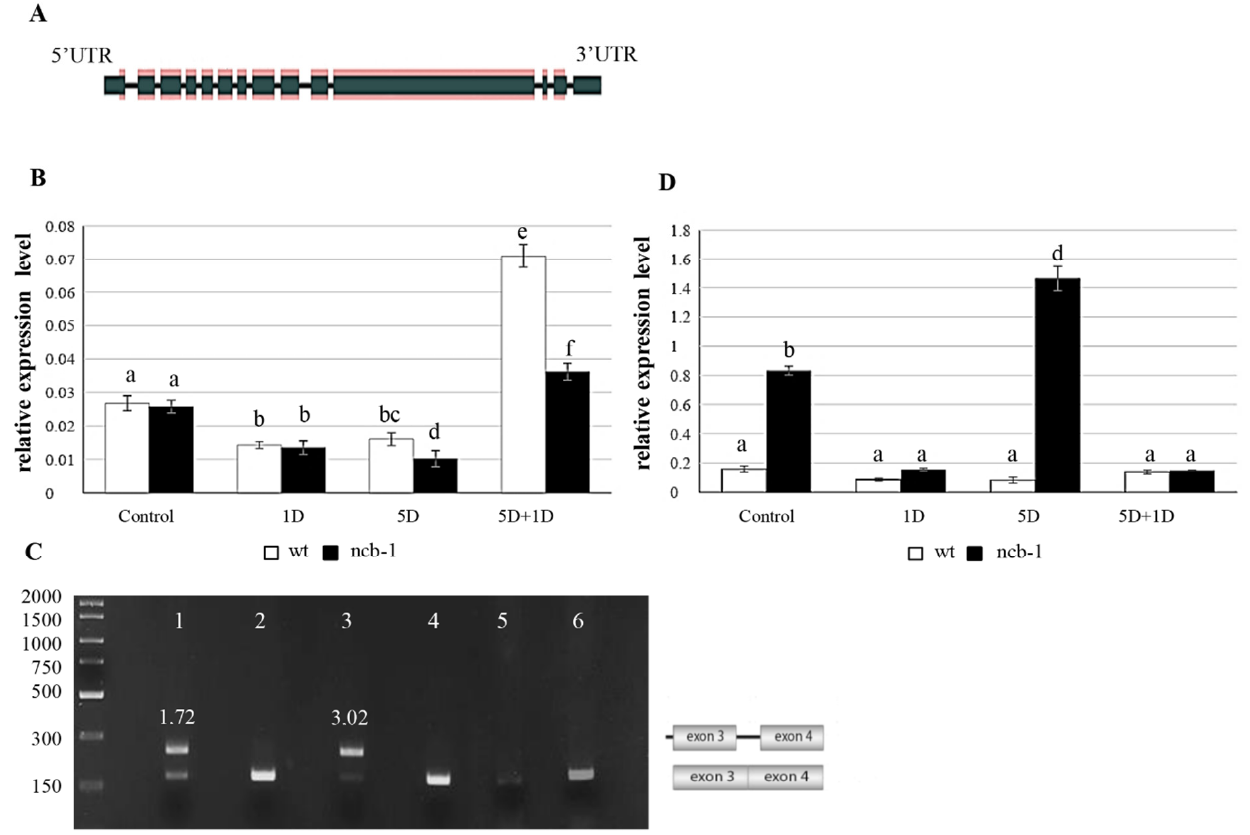
Figure 5. Structure of the largest RPB1 subunit for RNA polymerase II in Arabidopsis thaliana (the thicker dark green bars represent exon sequences, and the thinner bars indicate intron sequences) [55] ( A ), Analysis of quantity and ratio of isoforms mRNA RPB1 with intron retention and without introns. The relative expression of transcripts of RPB1 with exon 8 and 9 ( B ), Gel separation of PCR products with specific primers to exon 3 and 4 mRNA RPB1. line 1—Control ncb-1 -; line 2—Control wt; line 3—hypoxia ncb-1 ; 4—hypoxia wt; 5—five-day hypoxia and one day reoxidation ncb-1 ; 6—five-day hypoxia and one-day reoxidation wt ( C ), The relative expression of transcripts of RPB1 with intron 3 in wt and ncb-1 ( D ). Variants labeled with the same letters are not significantly different ( p ≤ 0.05). 1D—one-day hypoxia, 5D—five-day hypoxia, 5D + 1D five-day hypoxia and one-day reoxygenation.